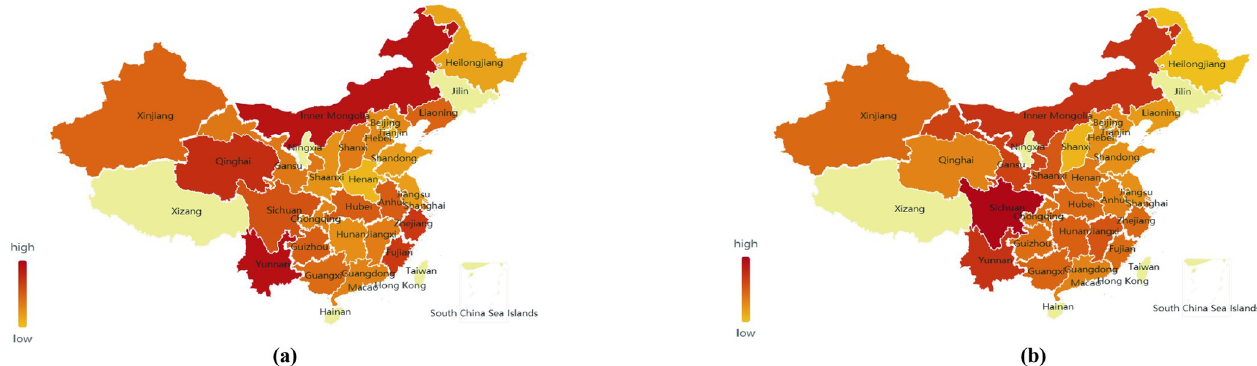
Fig 8. February 2019 (a) and February 2020 (b) National carrot price